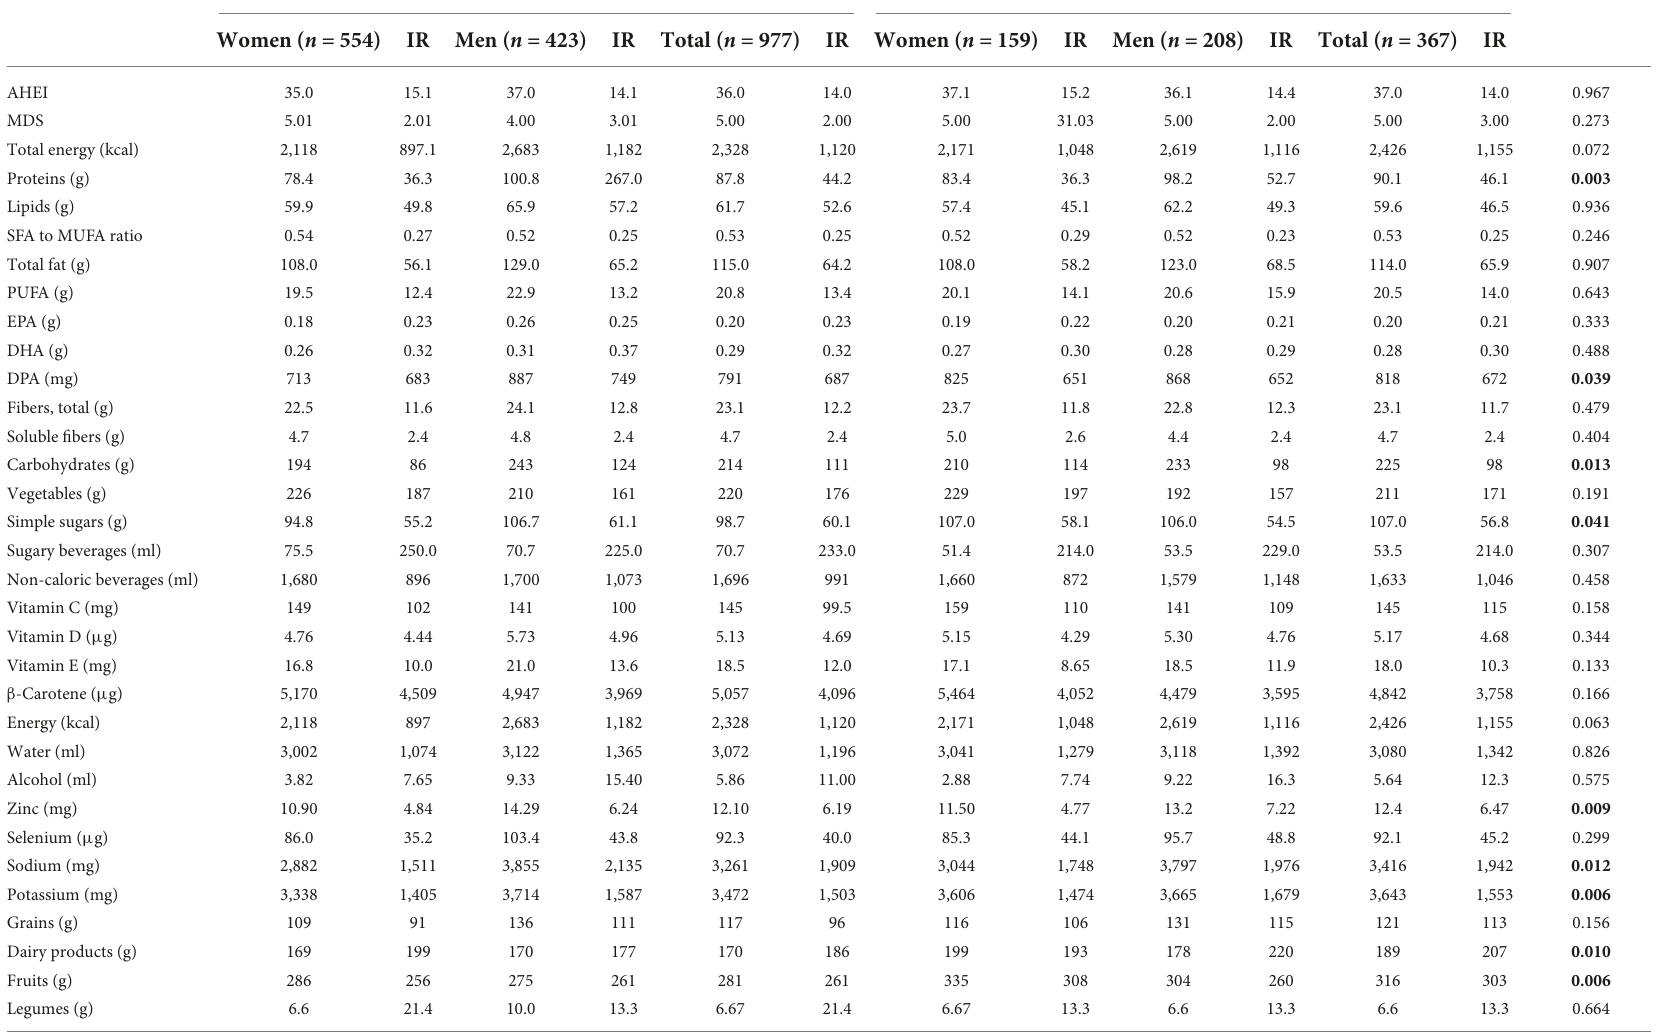
TABLE 2 Distribution of AHEI, MDS, and selected nutrient intakes of participants per day based on gender and MetS status. Variable a Participant without